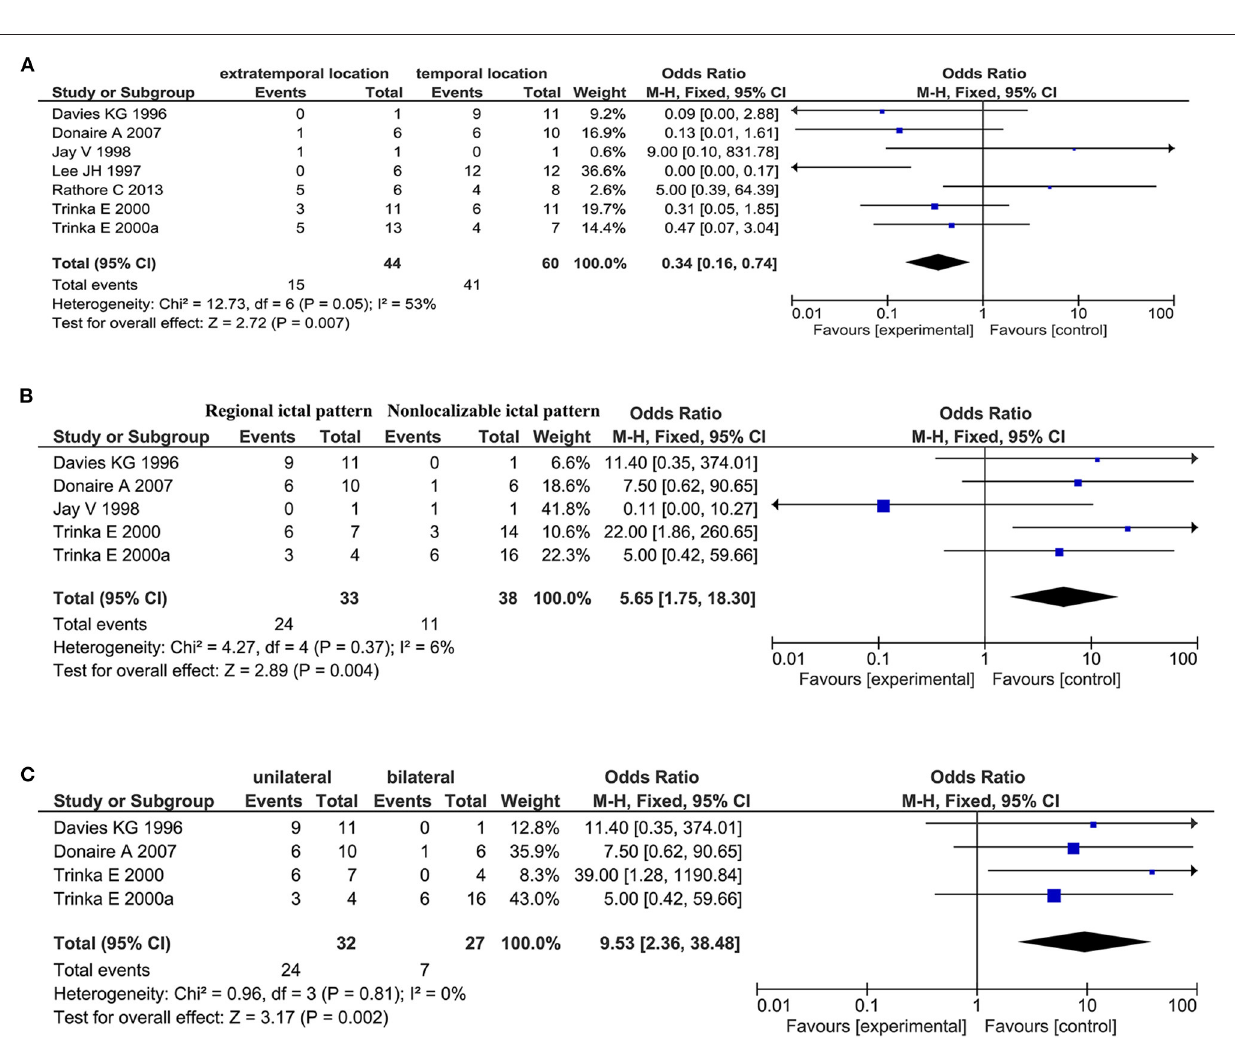
FIGURE 4 | Meta-analysis of ictal EEG findings. (A) Forest plot showed a temporal location of only lesion was associated with favorable outcomes in patients. (B) Forest plot showed a regional ictal pattern of EEG findings was associated with favorable outcomes in patients. (C) Forest plot showed favorable outcomes were achieved in patients with unilateral ictal EEG